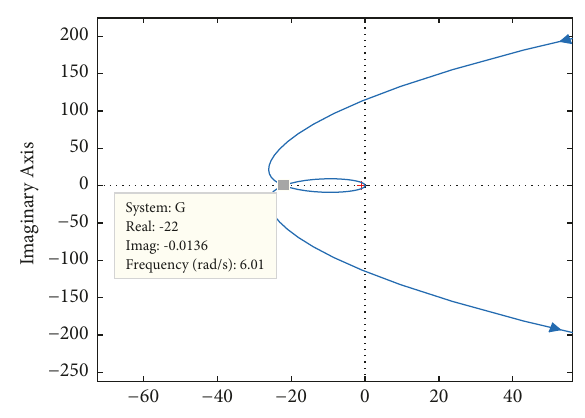
Figure 9: Polar plot of 𝐺(𝑗𝜔)